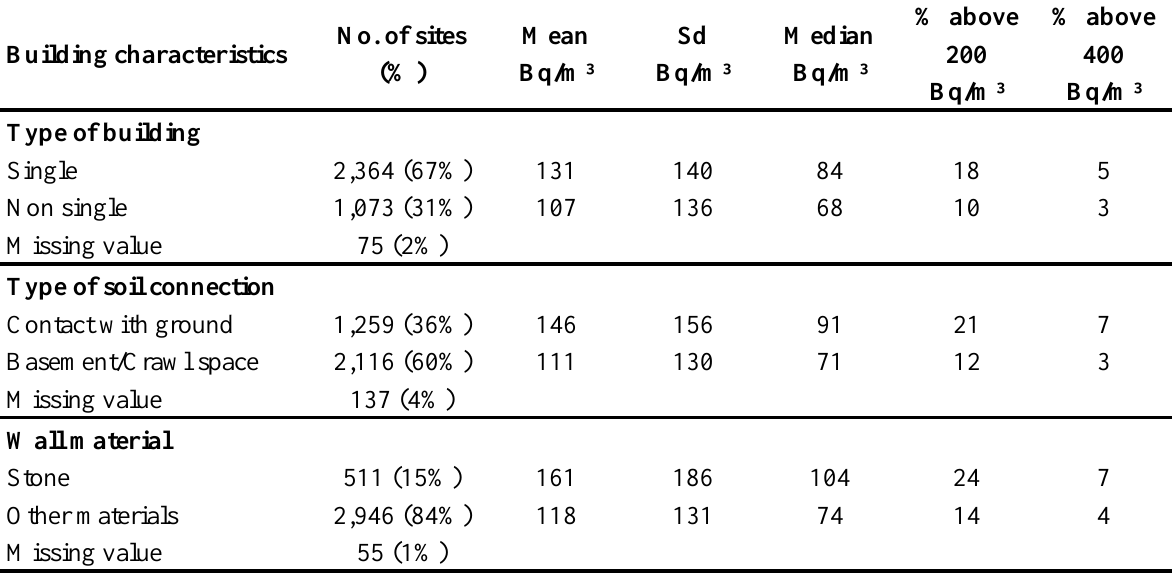
Table 3. Summary statistics of indoor radon concentration by building